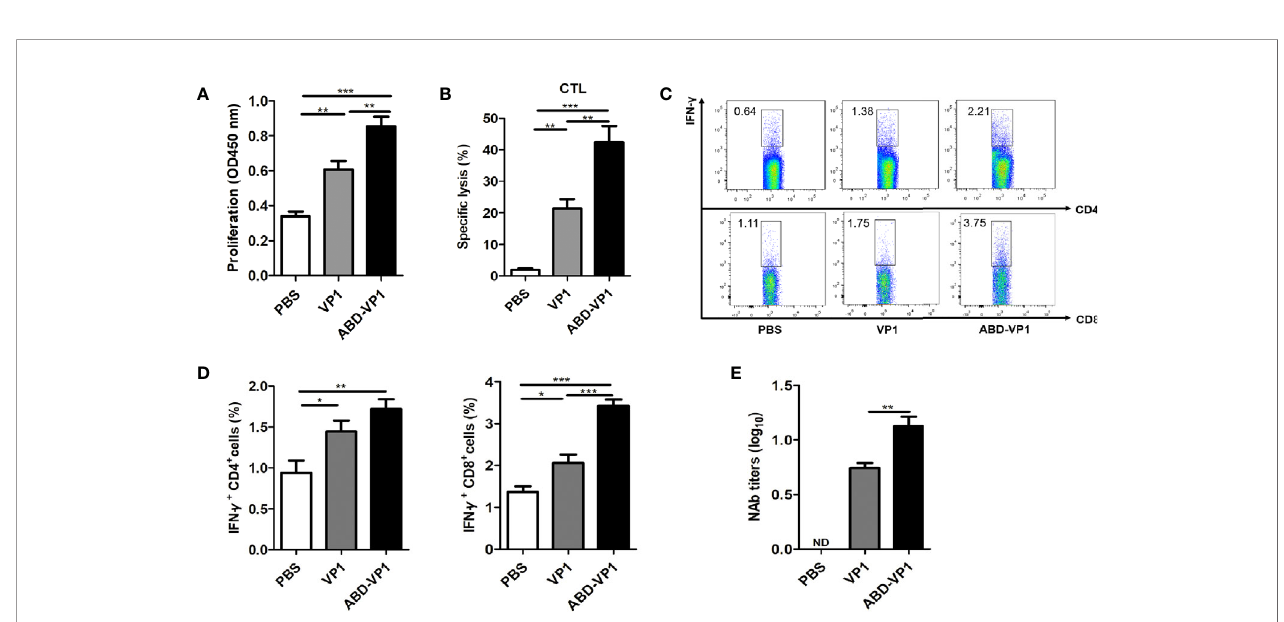
FIGURE 4 | ABD-VP1-induced splenic T cell immune responses. (A) CVB3 -speci fi c T cell proliferation in the spleens of immunized mice. (B) CVB3 -speci fi c CTL activity in the spleens. (C) Percentages of IFN - g + CD8 + and IFN - g + CD4 + cells in the spleens (unstimulated background has been subtracted). (D) Statistical analysis of (C) . (E) Levels of serum neutralizing antibody in immunized mice. Each group contained 6 mice. *P < 0.05; **P < 0.01; ***P <